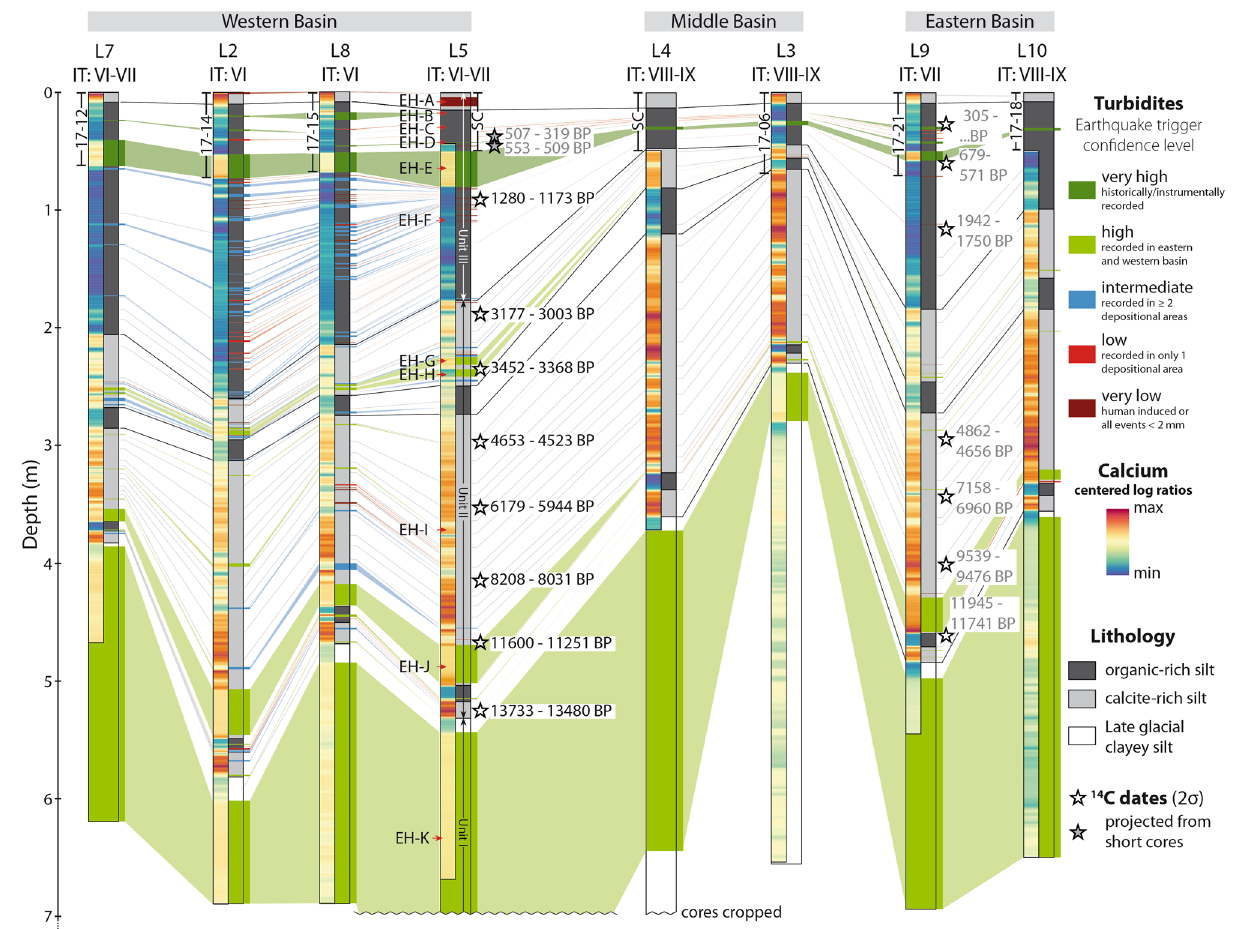
Figure 4. Correlation and general lithology of sediment cores in Wörthersee. The uppermost part of the composite sediment cores consists of short sediment cores (indicated by the core names or “SC” when the Kullenberg trigger core was used). Depending on the distribution of turbidites, we assign an earthquake trigger confidence level to each turbidite-interval. The background-sedimentation can be divided into three main lithologies: (i) partly laminated dark organic-rich silt with relatively low amount of calcite; (ii) laminated calcite-rich silt and iii) grey, laminated late glacial clayey silt 48 . As indicated by the distribution of calcium in the glacial clayey silts (unit